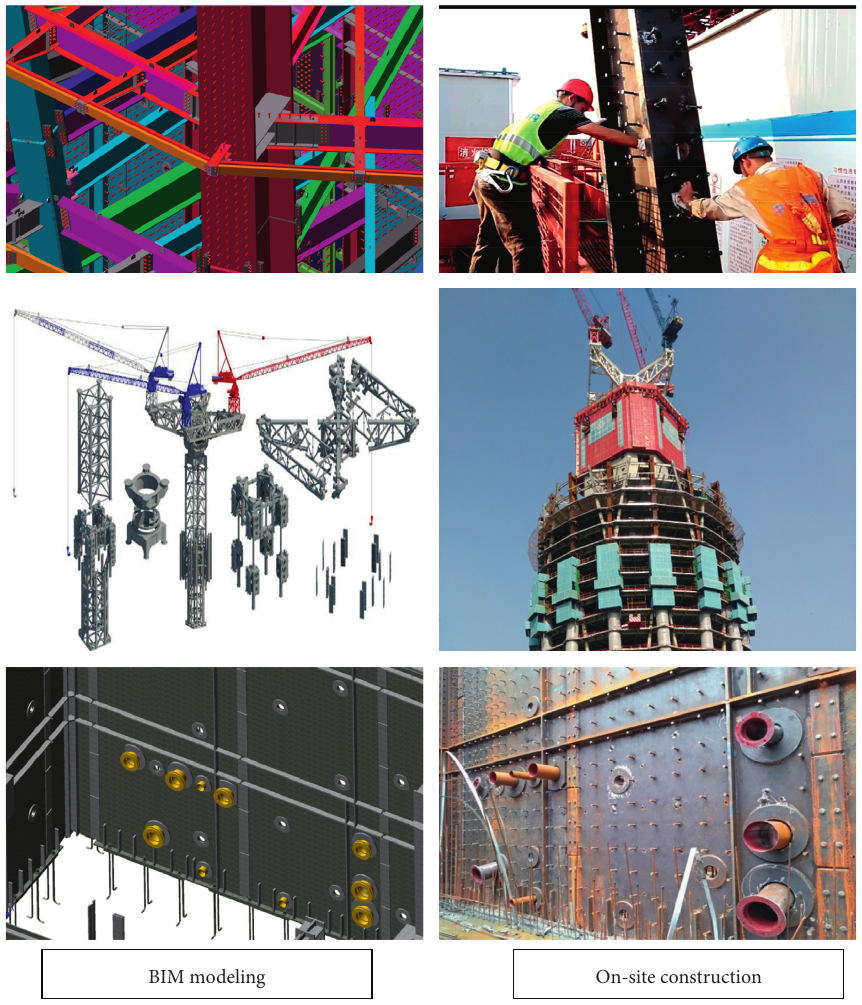
Figure 18: BIMs and process management on